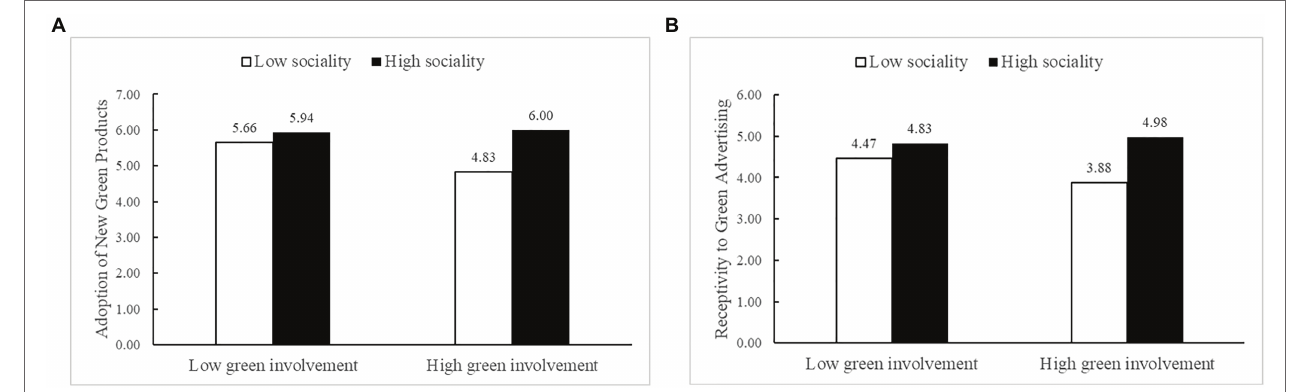
FIGURE 2 | Means of the variables at different levels of green involvement. (A) Means of the adoption of new green products at different levels of green involvement. (B) Means of the receptivity to green advertising at different levels of green